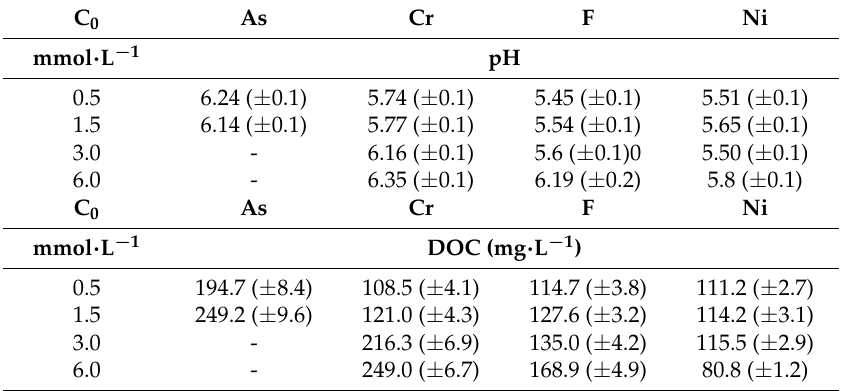
Table 5. pH and DOC in equilibrium solutions after As, Cr, F, and Ni desorption from wheat